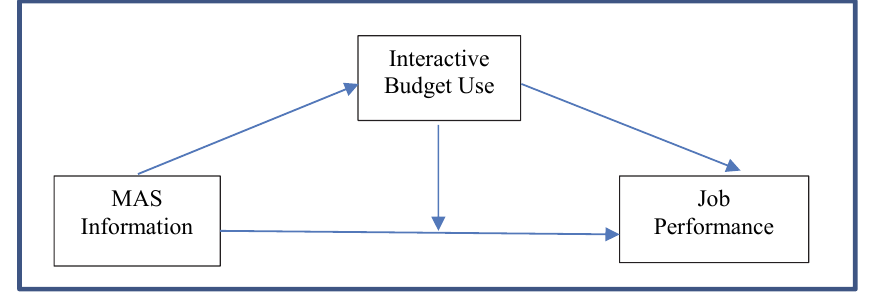
Fig. 1. Conceptual of Research